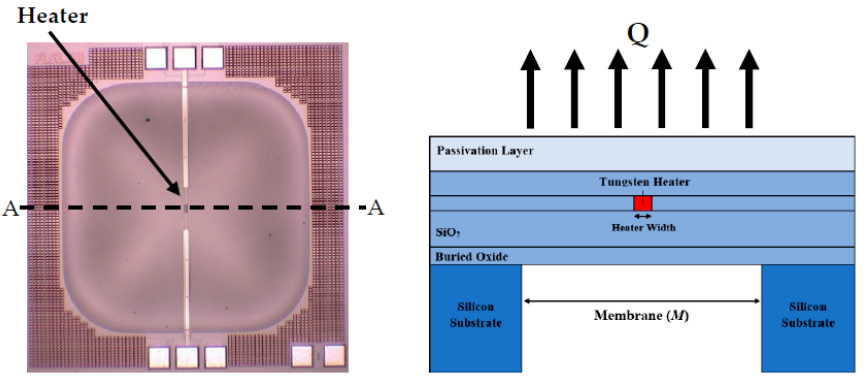
Figure 2. An optical micrograph of a recent thermal conductivity detector with a schematic illustration across the cut-line A-A. A micro-heater uses Joule heating to increase its temperature and heat transfer into the surrounding environment will then occur following Fourier’s